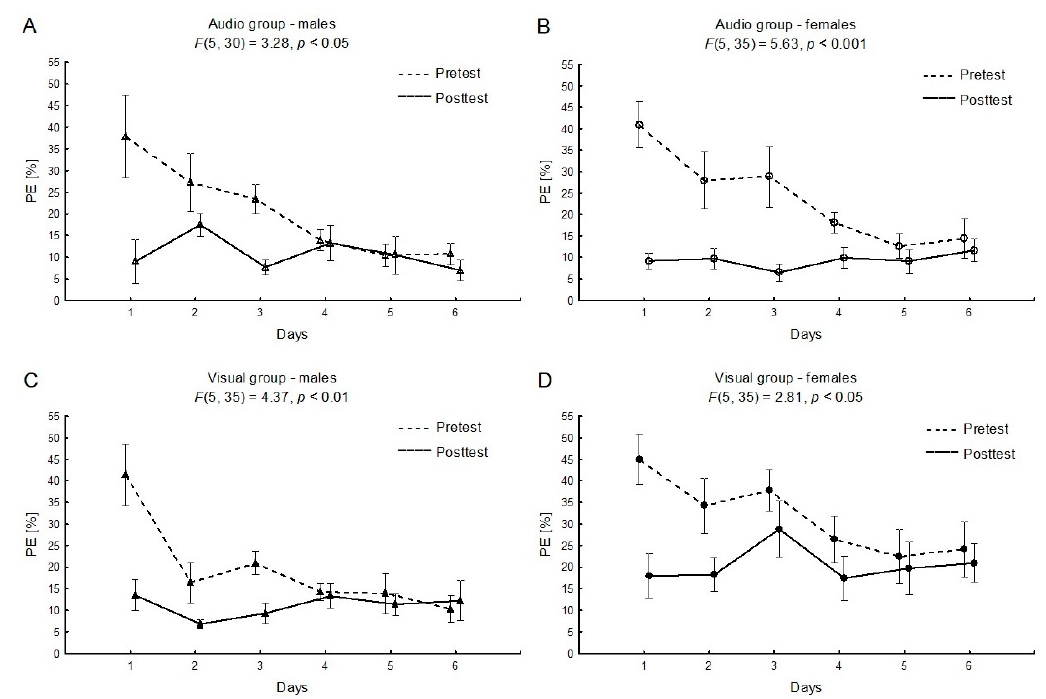
Figure 2. The mean relative values and standard error of measurements of the performance error (PE) for the “session × time” factor (the pretest vs. the posttest), separately for males and females, for the audio ( A , B ) or the visual feedback ( C , D ). Int. J. Environ. Res. Public Health 2020 , 17 , x